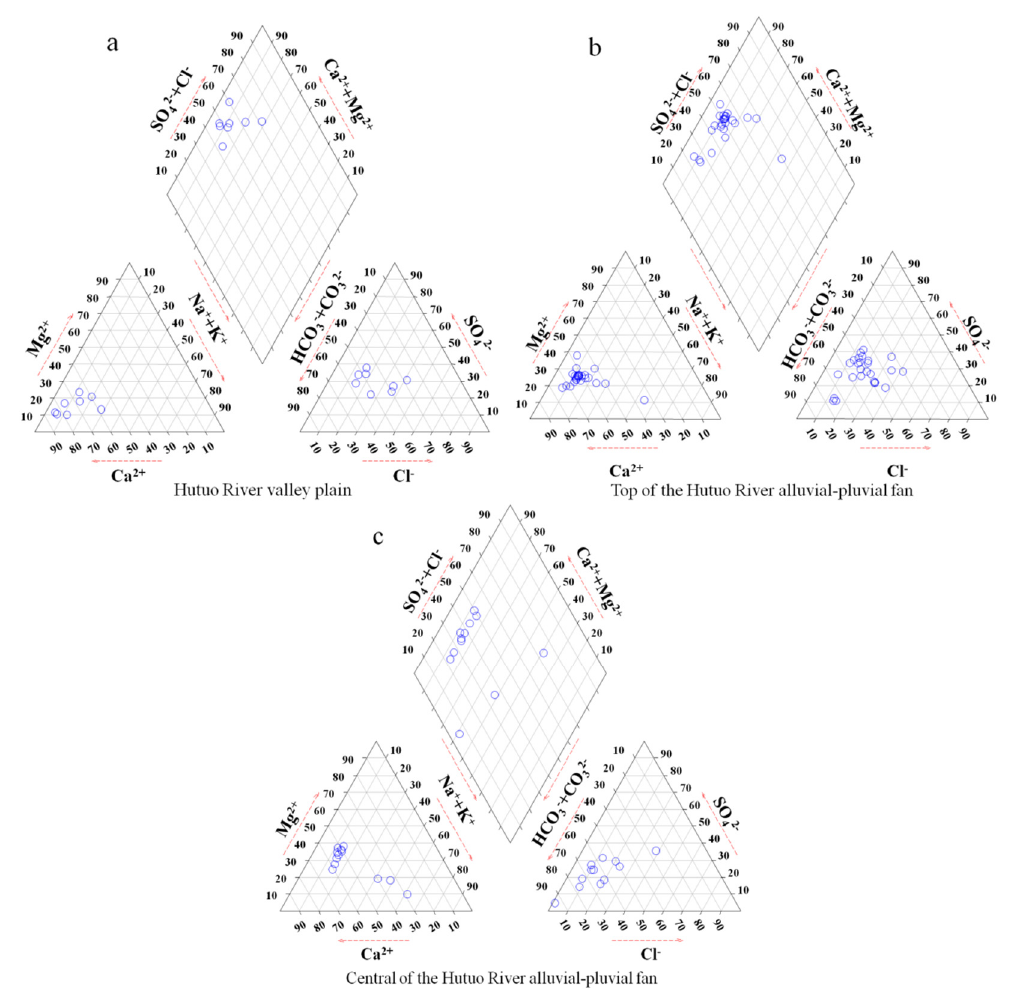
Figure 3. Piper diagram of groundwater in Hutuo River alluvial-pluvial fan. Int. J. Environ. Res. Public Health 2020 , 17 , x FOR PEER REVIEW